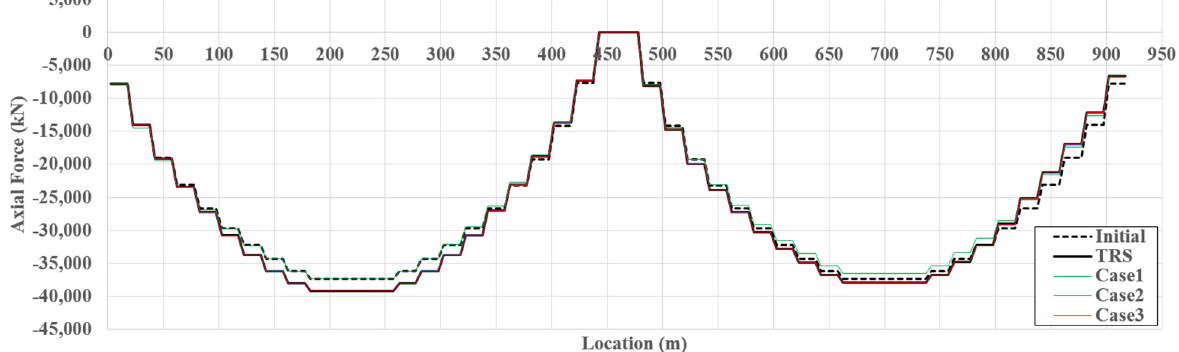
Figure 9. Example of estimated girder axial force for TM4.